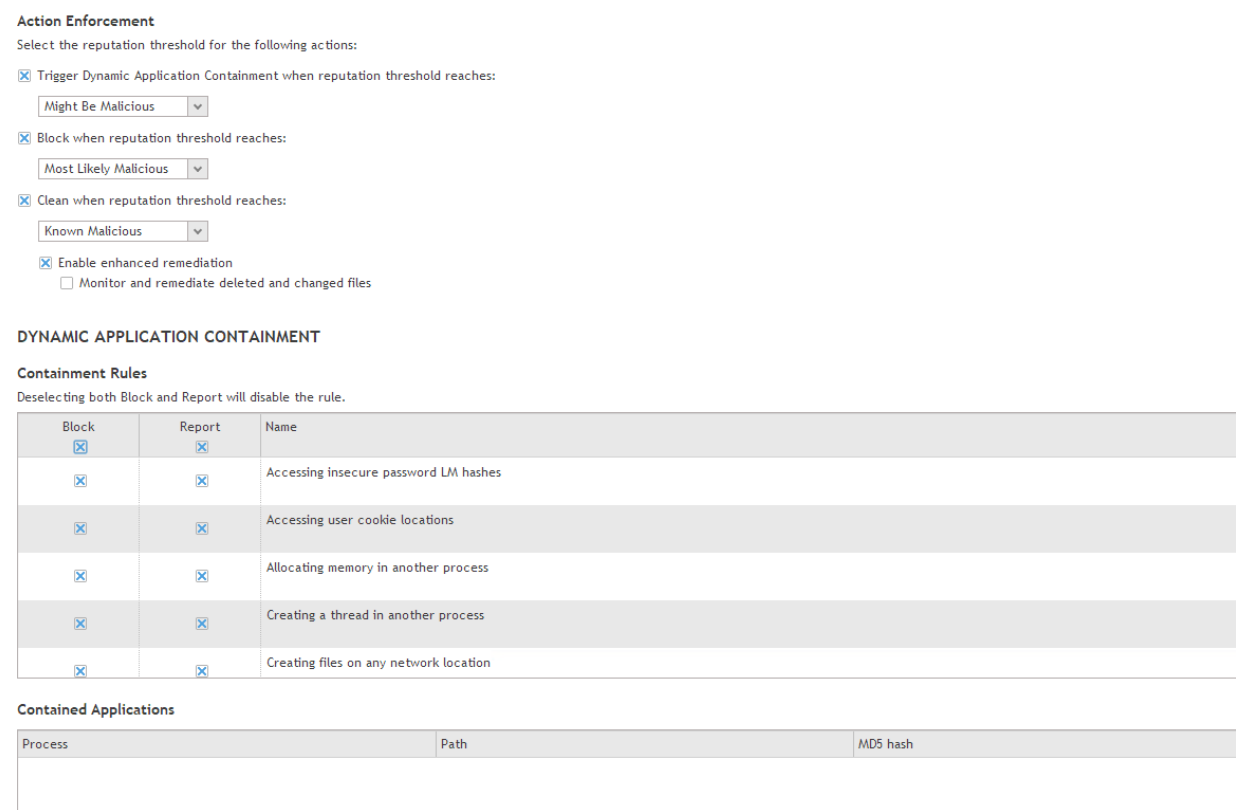
Figure 15. An excerpt of the settings that were enabled in McAfee Endpoint Protection.